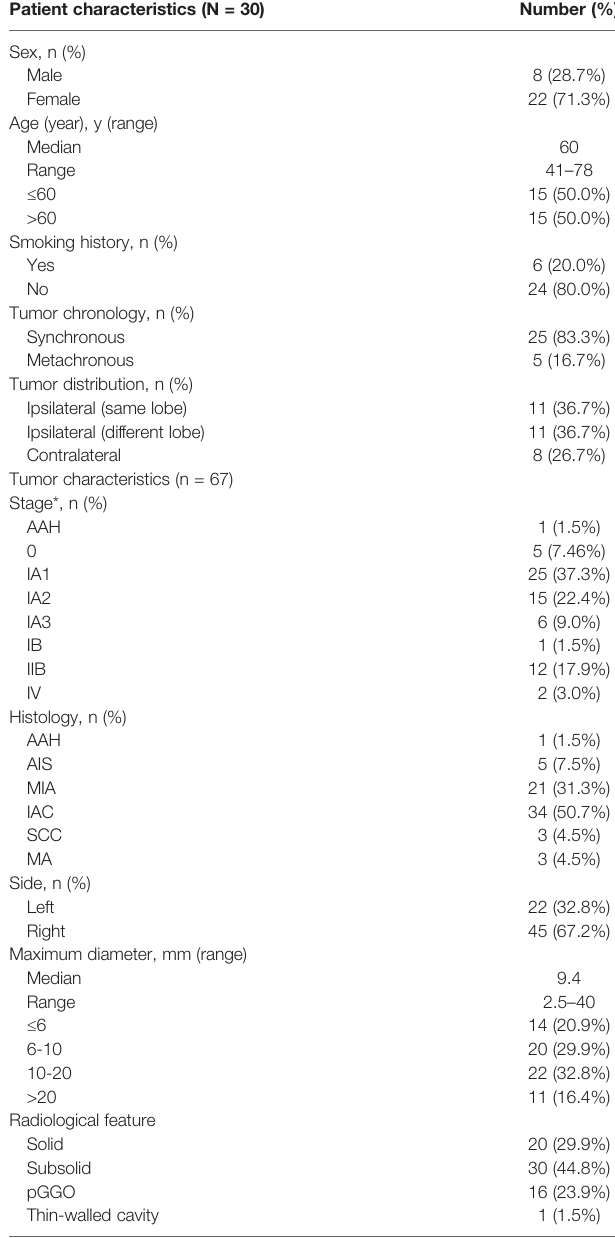
TABLE 1 | Clinical and radiological characteristics of 30 patients with